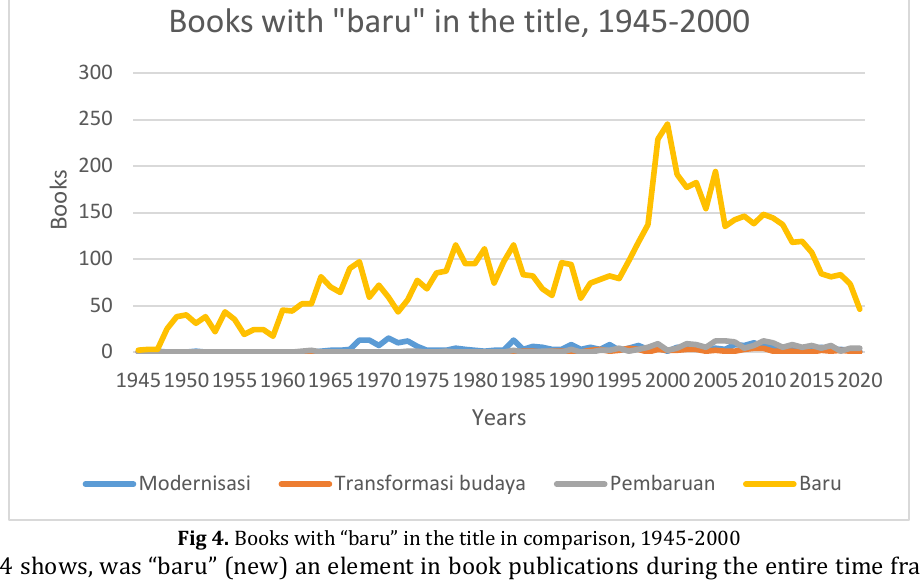
Fig 4. Books with “baru” in the title in compar ison,